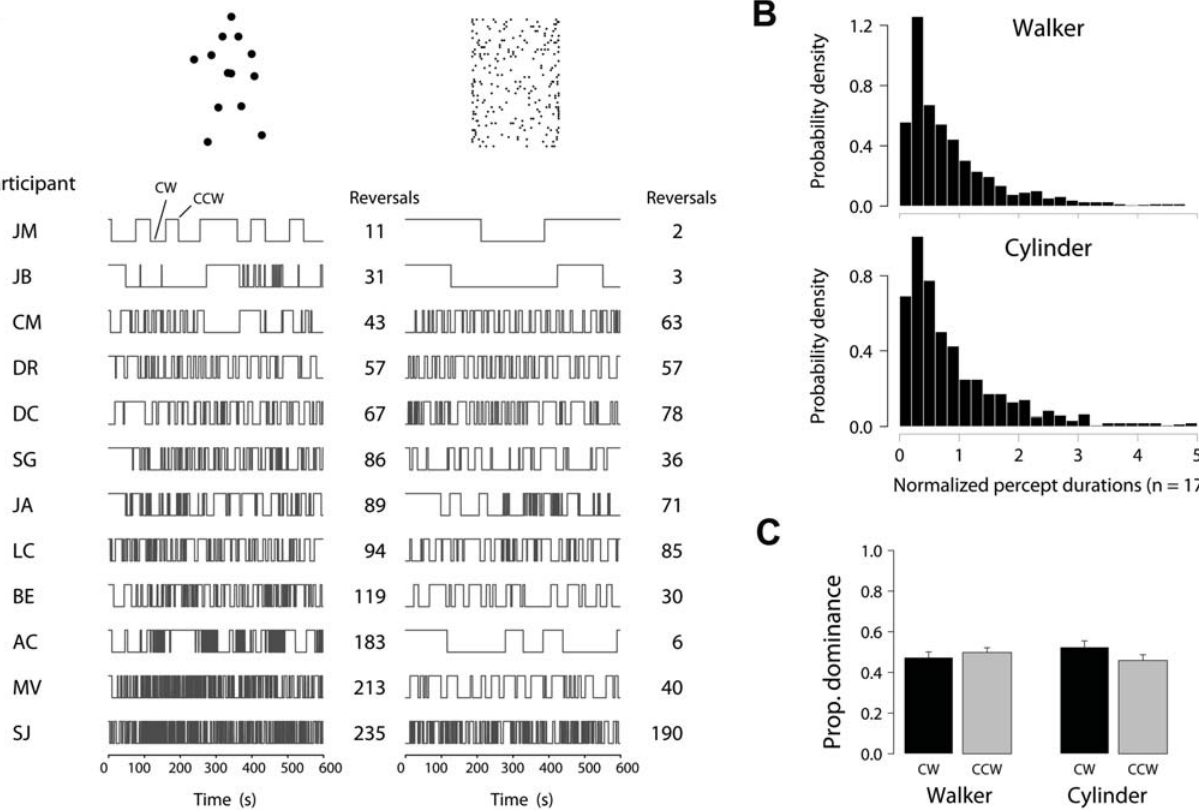
Figure 2. Experiment 1 results. (A) Alternation of the stimuli between clockwise and counter-clockwise over 600 s trials. Participants experienced quite varied numbers of reversals for both stimuli. Several participants reported transient phases in which the walker briefly ‘collapsed’ or ‘danced’ (see Materials and Methods); for 3 of the 17 participants these periods accounted for approximately 10%–20% of trial time. For the other 14 participants, these periods were rarely experienced and accounted for less than 1% of total trial time. (B) Normalized percept durations across all observers is plotted (each observer’s durations divided by the mean duration for that participant). For both stimuli we see a distribution with a particularly fast rise and rightward tail. Durations in which neither CW nor CCW were perceived were excluded from this analysis. By multiplying bin height by bin width (0.2 units each), we get the proportion of all responses falling in a particular bin. The horizontal axis upper limit is set at 5 normalized units for illustration; a very small number of longer normalized durations are not shown for this reason. (C) Mean proportion dominance time for CW/CCW percepts for the walker and cylinder stimuli (n=17, 170 mins total per stimulus). Error bars indicate standard error.